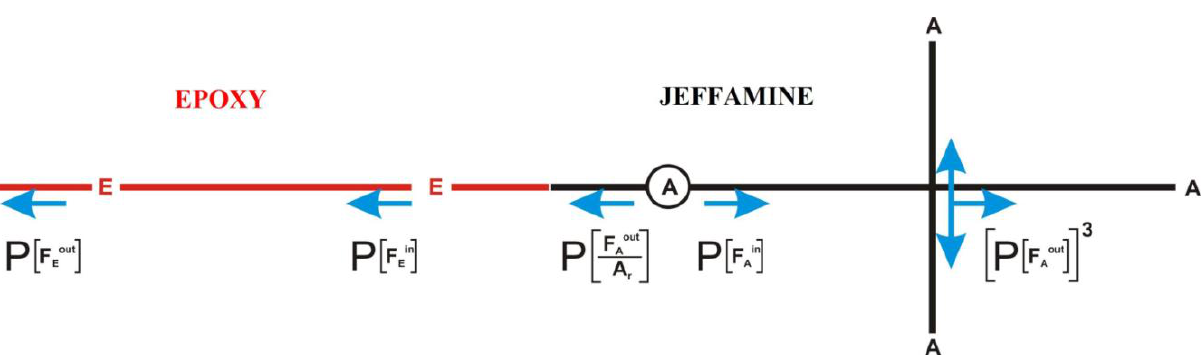
Figure 7. Scheme of the probability